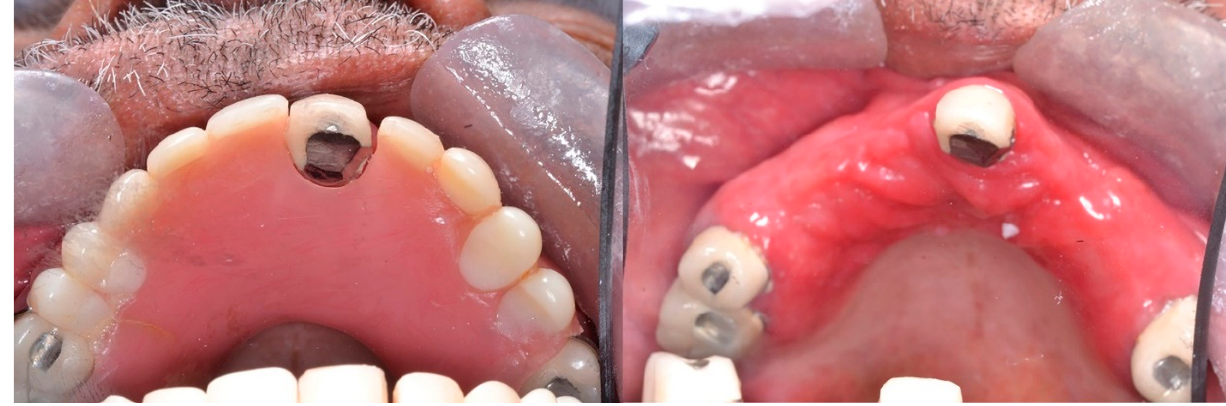
Figure 3. Diffuse involvement of the denture-bearing mucosa mirroring the partial denture base. Type III: Additionally known as inflammatory papillary hyperplasia, the denture- bearing mucosa shows a granular appearance (Figure 4).